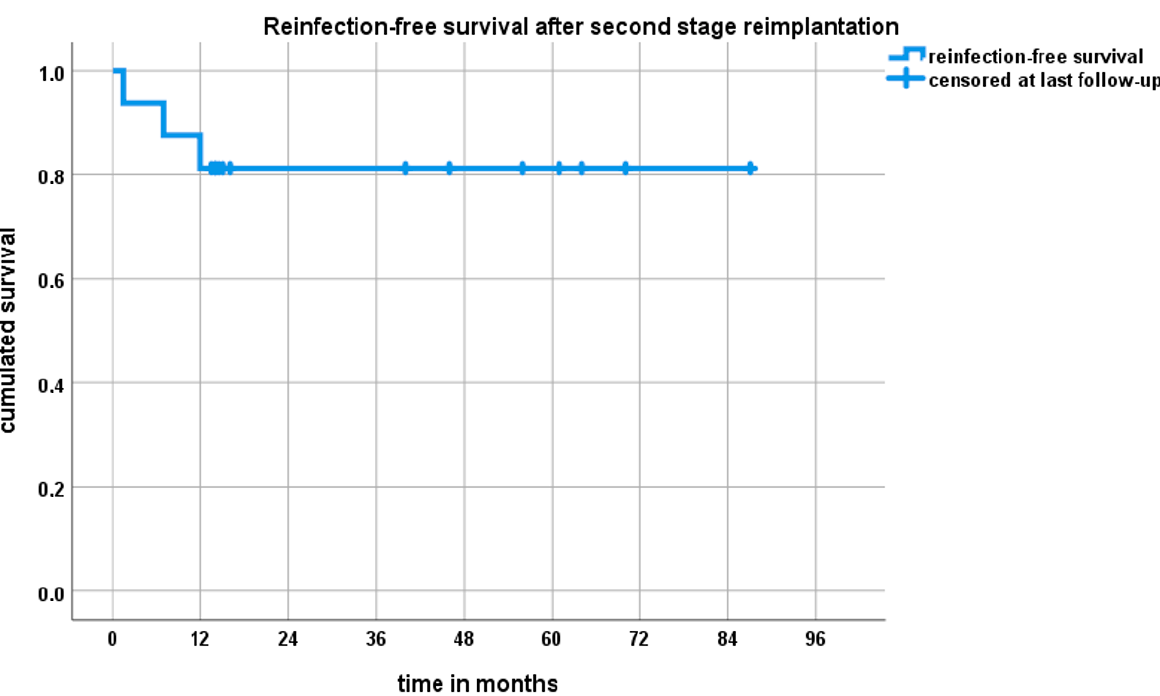
Figure 5. Kaplan–Meier survival curve after two-stage prosthesis exchange following periprosthetic shoulder infection. Three patients showed recurrence of joint infection within 12 months. After 12 months, there were no further reinfections. Table 3. Overview of the included patients with microbial spectrum, replanted prosthesis model and revision, as well as surgical and general complications. C. acnes : Cutibacterium acnes , MRSE : Methicillin-resistant Staphylococcus epidermidis , MSSE : Methicillin-sensitive Staphylococcus epidermidis , E. facalis : Enterococcus faecalis , E. coli : Escherichia coli , S. aureus : Staph- ylococcus aureus , S. capitis : Staphylococcus capitis , RSA: reverse shoulder arthroplasty, CTA HA: large-head hemiarthro- plasty, RPHR: reverse proximal humerus replacement.